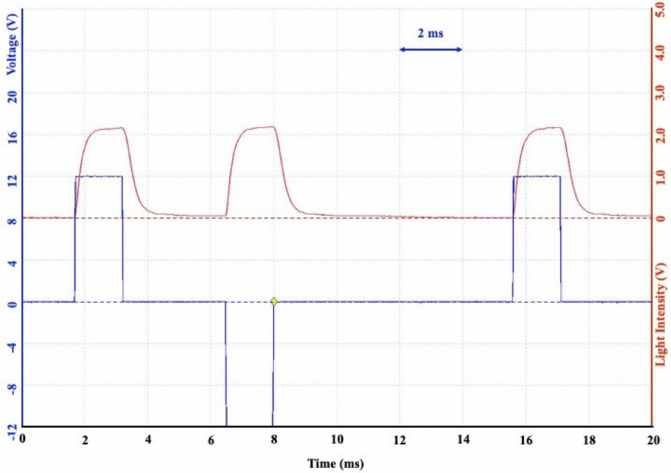
Figure 11. Light-throughput dynamic behavior of the other non-uniformly stacked SSD-LC panel for a linearly polarized incident beam.